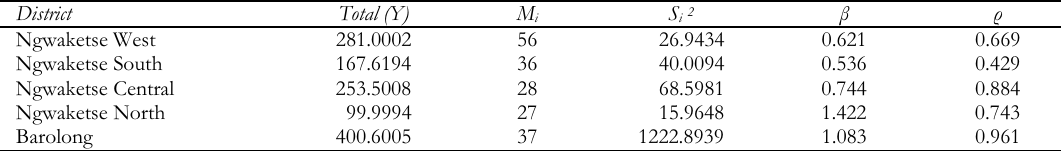
Population parameters (overall) for 1999/2000